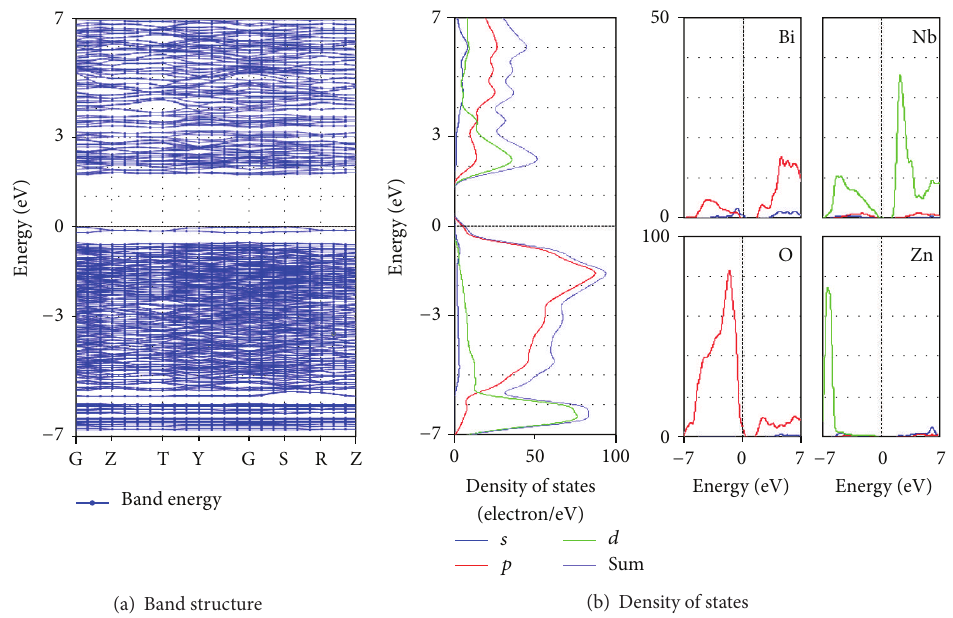
Figure 8: The band structure and DOS for the C-centered orthorhombic BZN ordered solid